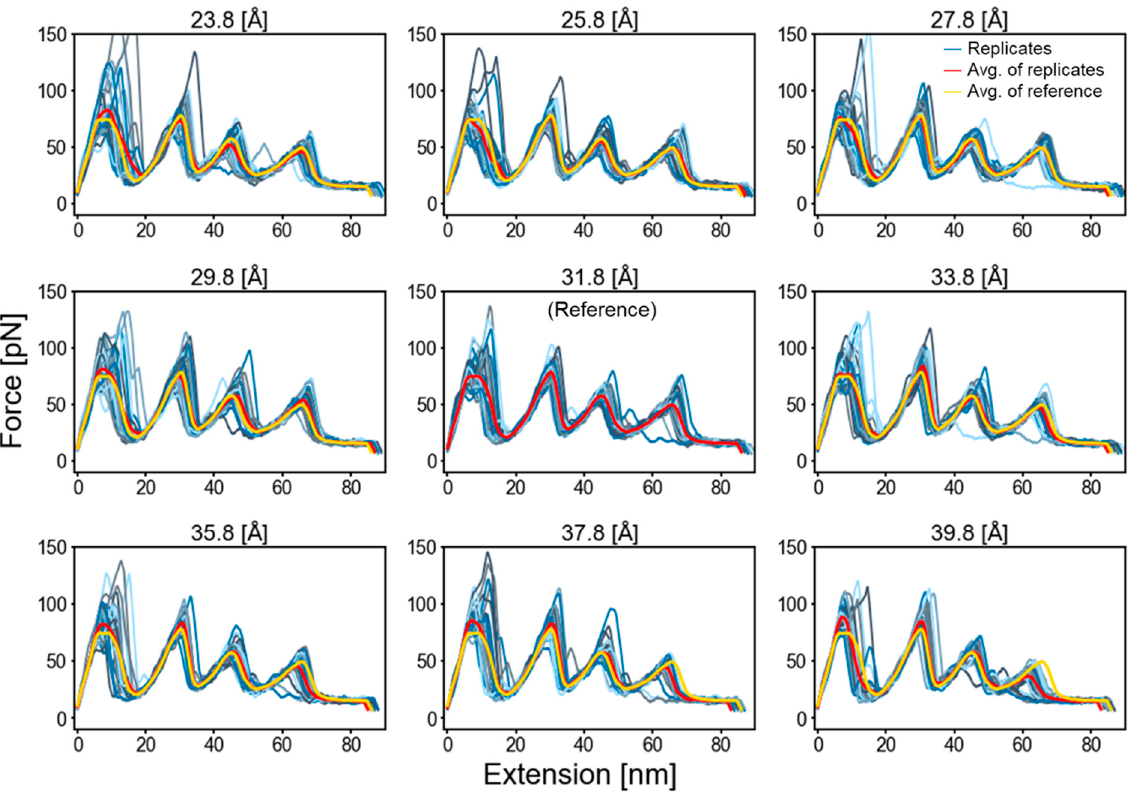
Figure 4. Effect of membrane thickness on 28 FEC profiles. The optimal (lowest energy, center plot) thickness is 31.8 Å [24].